Question: What type of chart is this?
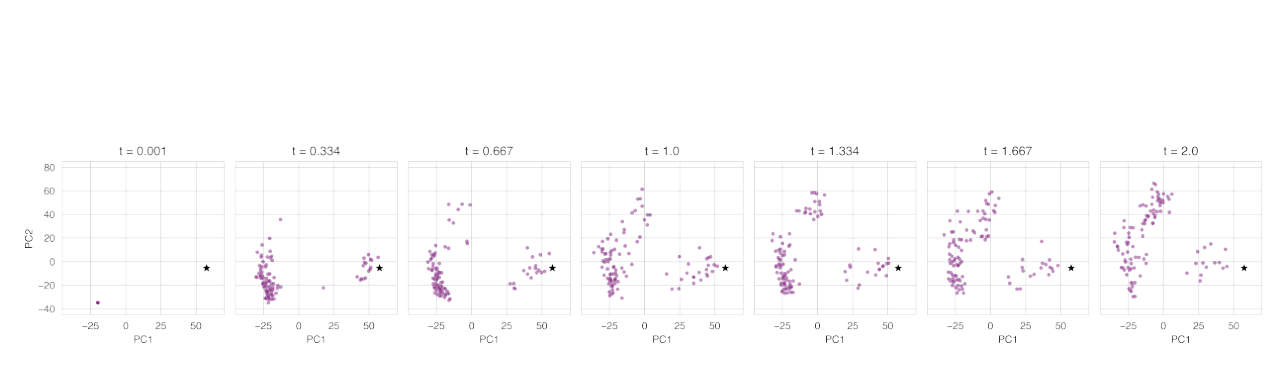
Answer: scatter